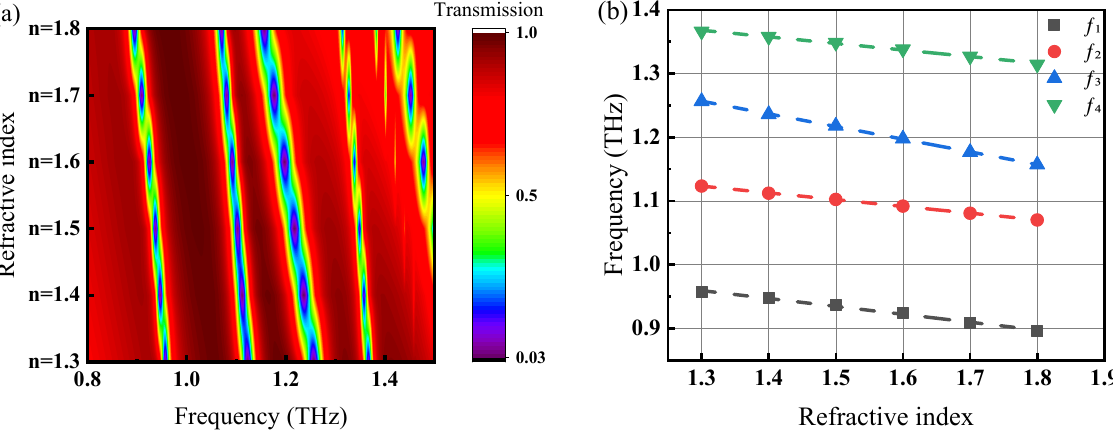
Figure 6. ( a ) Transmission spectra at h1 = 25 μm for samples with different refractive indices. ( b ) Sensing signal frequency versus refractive index for resonance.